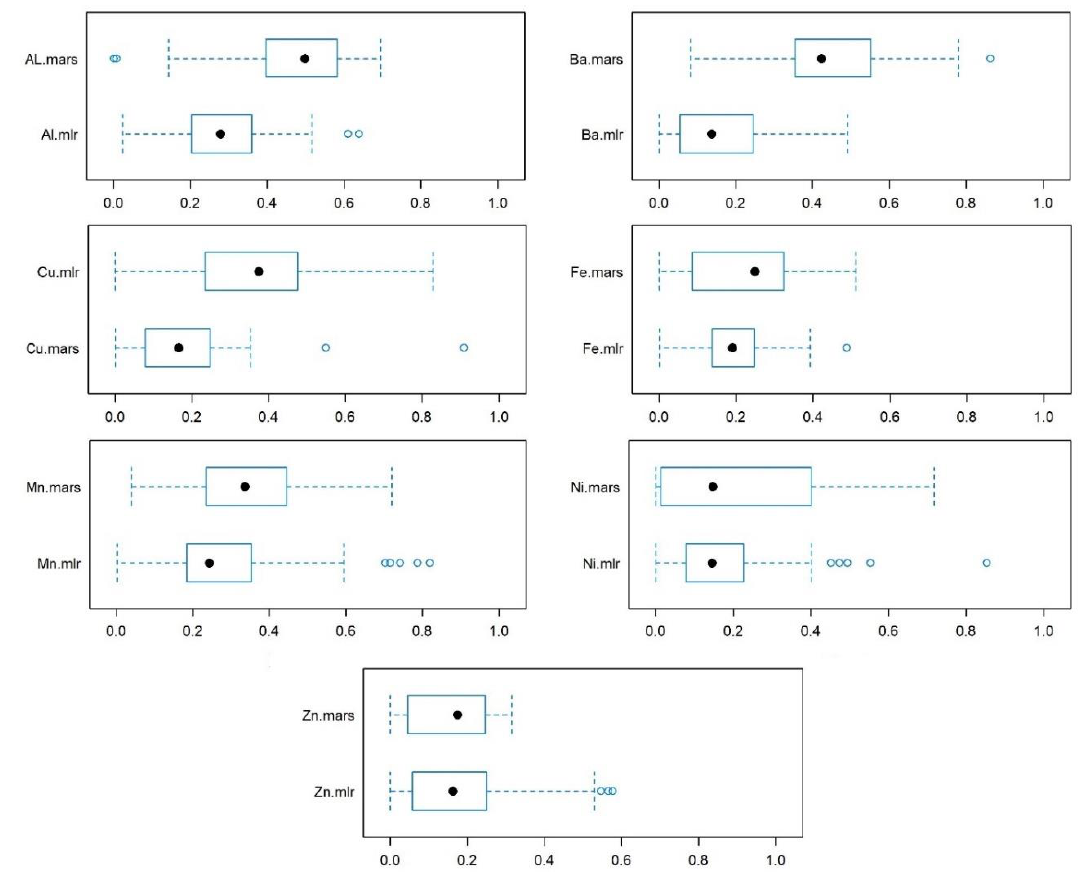
Figure 5. Relationship between humus content and elemental concentration of soil.